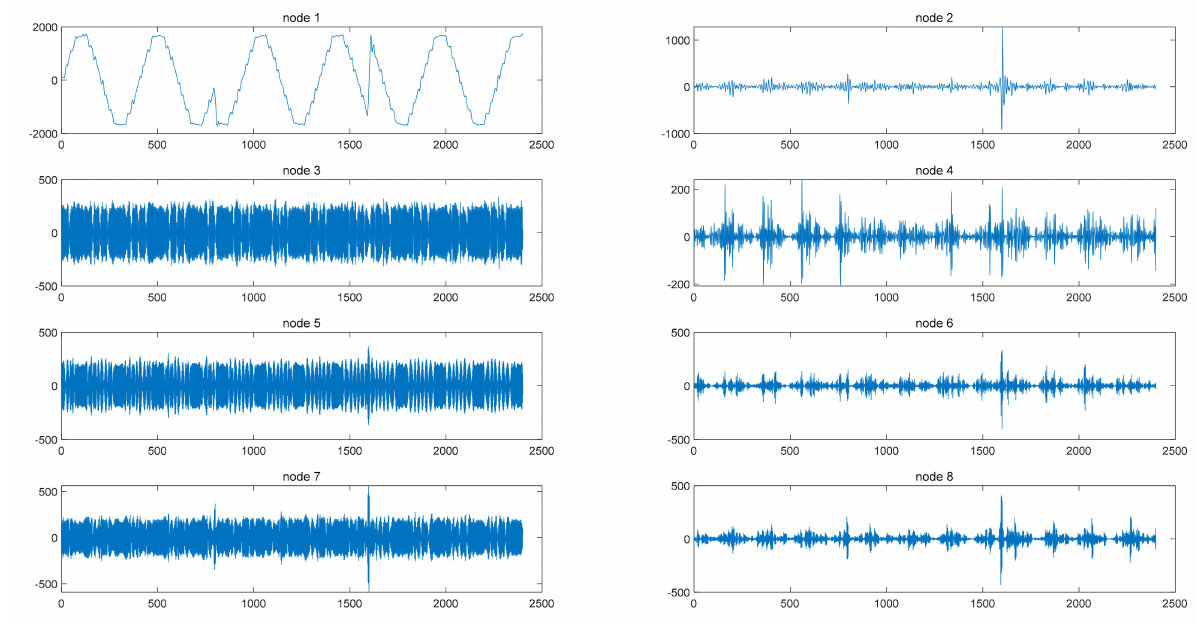
Figure 5. Reconstruction signals after three-layer wavelet packet